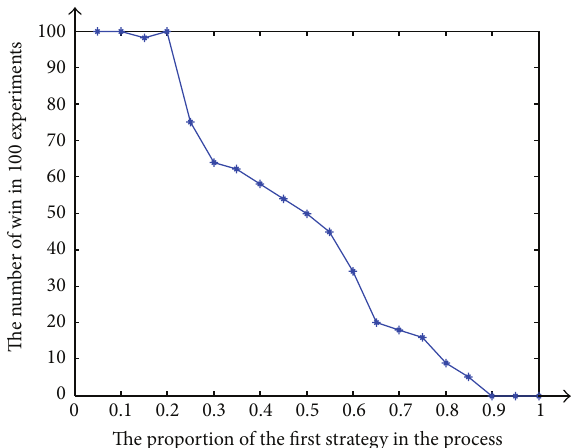
Figure 4: The Y-ray represents the number of win in 100 experi- ments. The X-ray represents the proportion of two strategies. There is constant noise in the model.